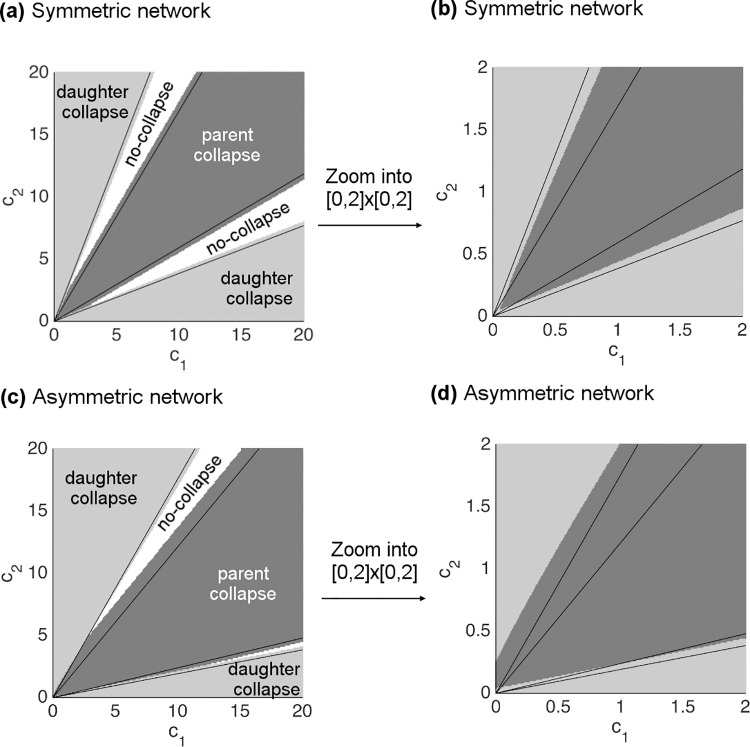
Comparison of approximate solutions with numerical solutions for the PC-1 (power-cost (PC) optimization beyond single branching).Approximate solutions define linear boundaries on the c1c2-plane between different categories of the solution space: collapse to daughter endpoint, collapse to parent endpoint, and no-collapse. The different categories calculated from numerical simulation are marked by different colors as indicated in the figure. (a) An example of symmetric branching in vessel radius with parameter values: |V0V1| = |V0V2| = |V1V2| = 1, r0 = 1.20, r1 = 1, and r2 = 1, where c1 and c2 take values in the range [0,20]. (b) Zoomed version of (a) into the plane [0,2] × [0,2] with the same resolution as in (a). (c) An example of asymmetric branching in vessel radius with parameter values: |V0V1| = 0.8, |V0V2| = |V1V2| = 1, r0 = 1.1, r1 = 0.85, and r2 = 1, where c1 and c2 take values in the range [0,20]. (d) Zoomed version of (c) into the plane [0,2] × [0,2] with the same resolution as in (c).